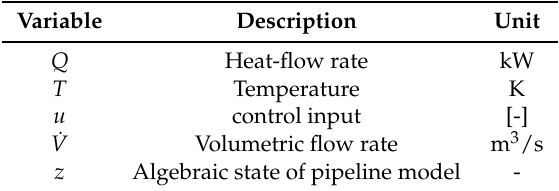
Table 2. Variables of system model and optimal-control